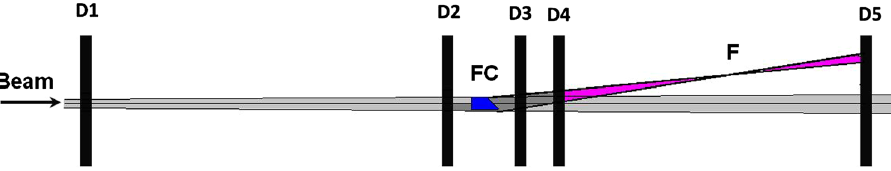
Fig. 1 A schematic view of the layout of the experiment for the measurement of multiple scattering of protons in the crystal deflectors. D1-D5 are the silicon microstrip detectors, FC is a bent focusing silicon crystal. Part of the beam after the bent crystal is deflected and focused at point F (focal